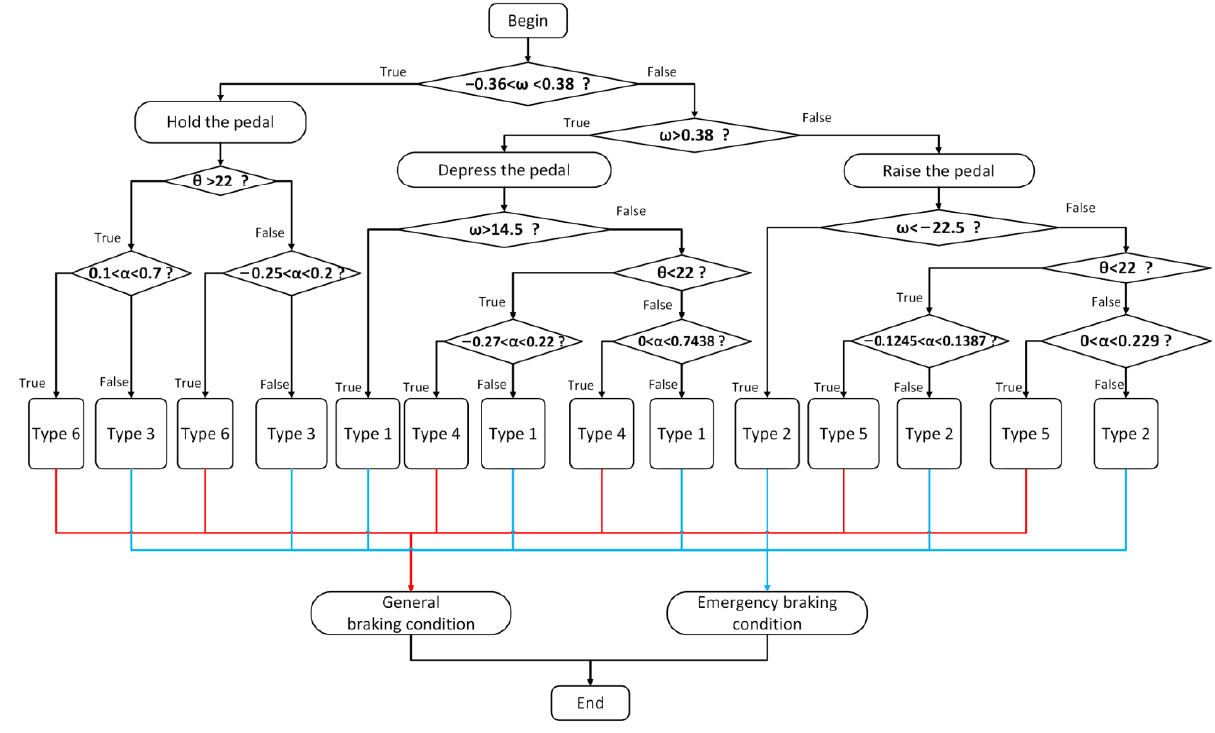
Figure 7. Braking conditions classification algorithm.